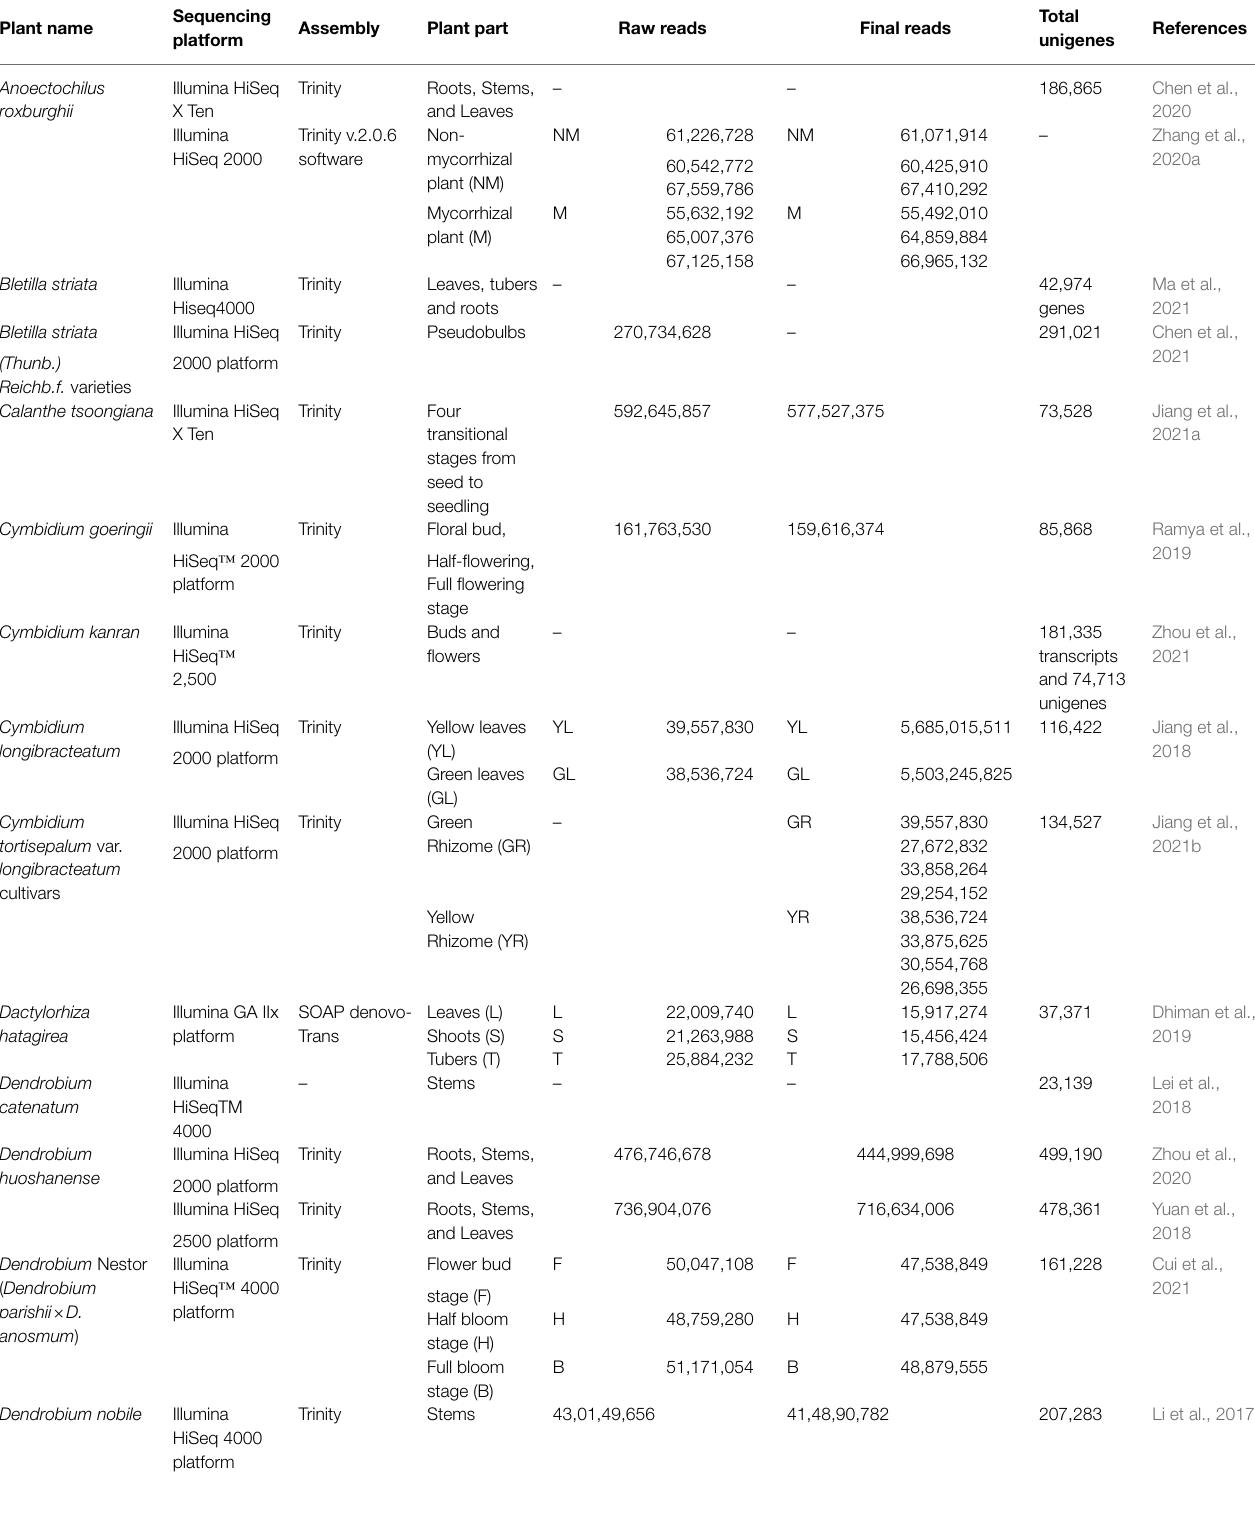
TABLE 1 | Enumeration of transcriptomic data in